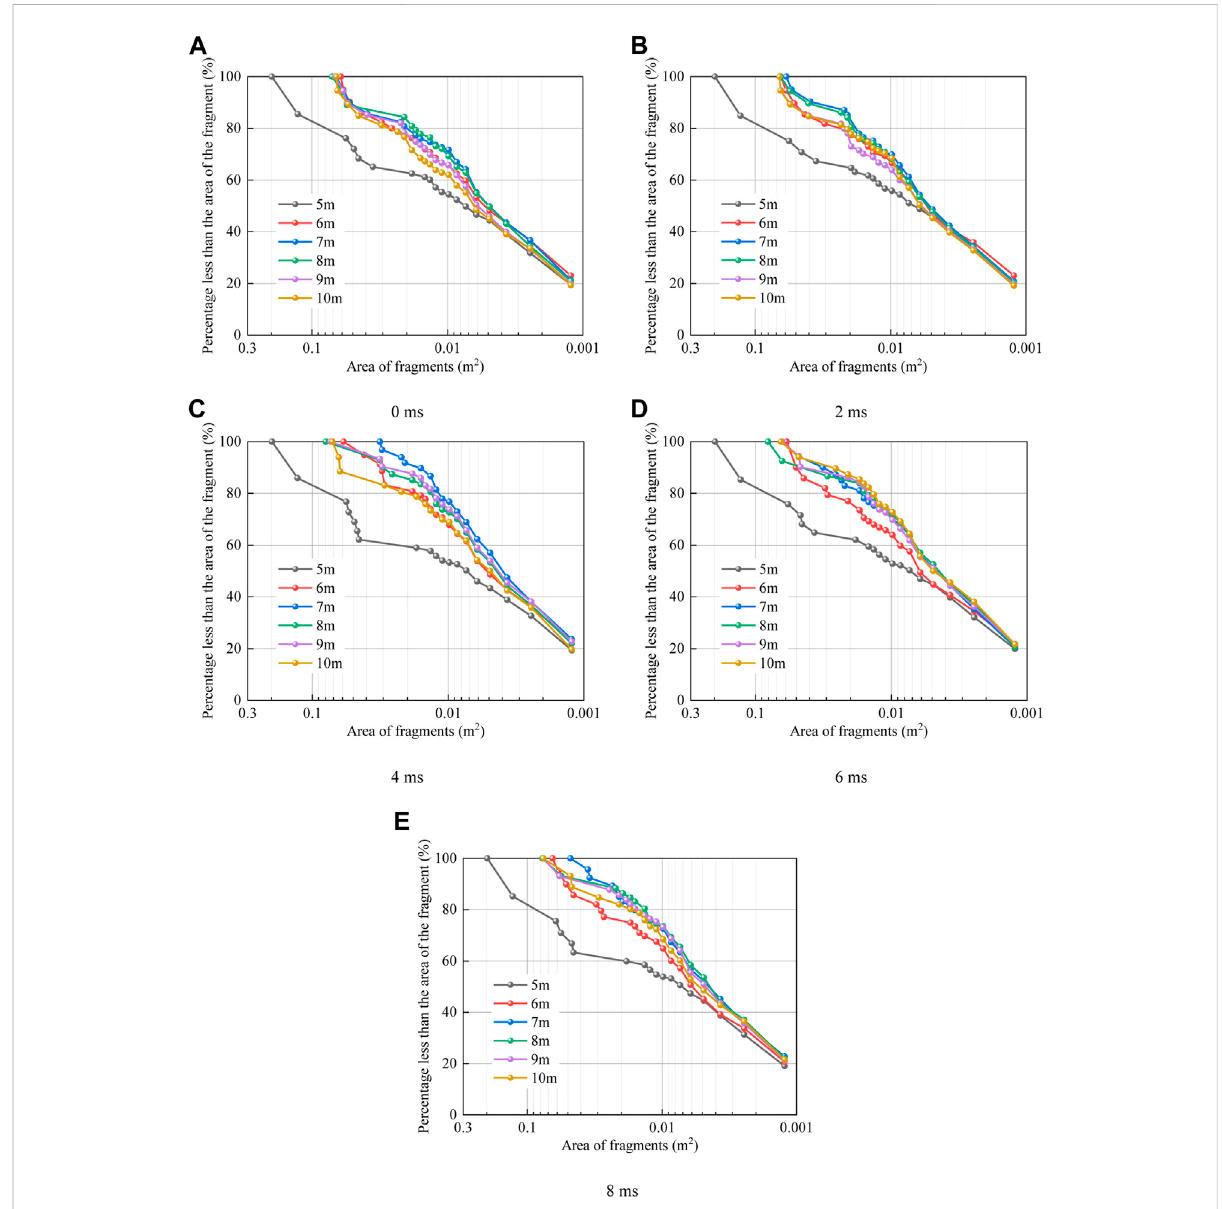
contact force around the blasthole is the largest. According to the statistics of the magnitude and direction of the contact force, it can be seen that the thickness of soft rock and the delayed initiation time affect the overall internal stress of rock mass after blasting. The angle of the contact force under each working case and the contact force value within the angle range are counted, and the results are shown in Figures 9,